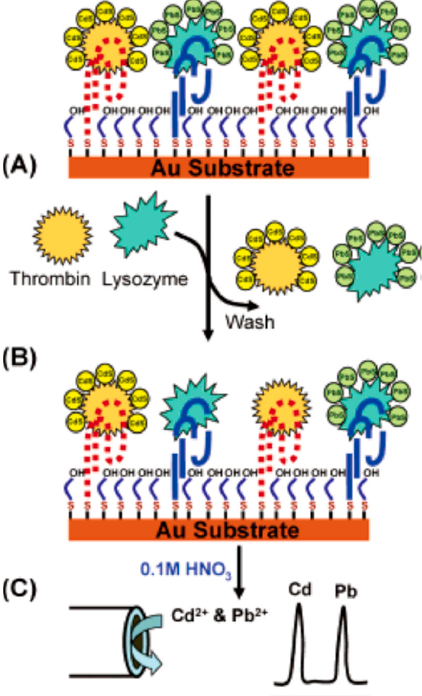
Figure 6. Operation of the aptamer/QD-based dual-analyte biosensor, through displacement of the tagged proteins with the target analytes. ( A ) Monolayer of thiolated aptamers is mixed with the bound protein-QD conjugates; ( B ) The tagged proteins is displaced by the sample; ( C ) The remaining captured nanocrystals are dissolved and apply their electrochemical-stripping detection [43].